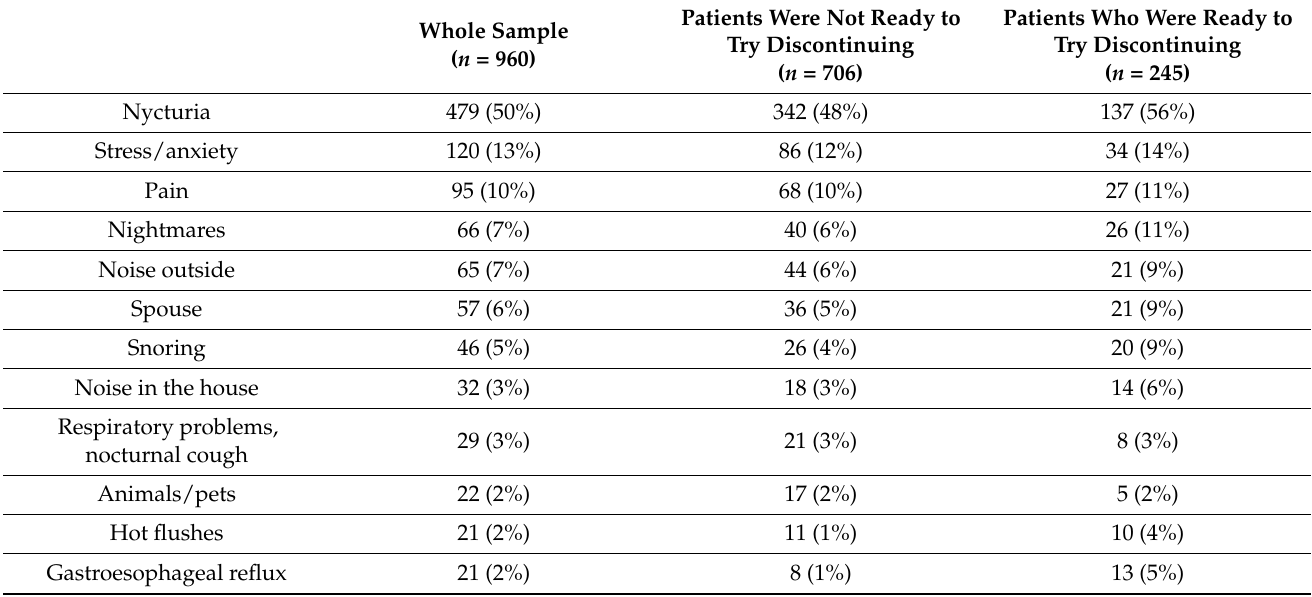
Table 2. Cause of nocturnal awakening. Data were missing for 9 of the 960